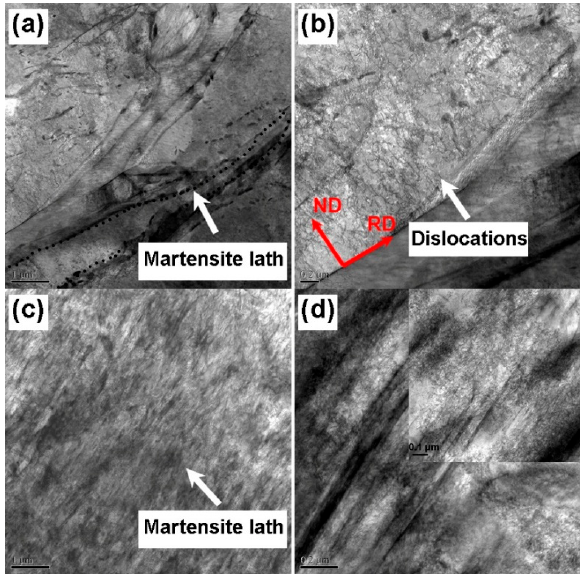
Figure 6. Transmission electron microscope (TEM) micrographs showing the morphology of rolled martensite and dislocation: ( a , b ) specimen rolled at room temperature; and, ( c , d ) specimen rolled at liquid nitrogen temperature.